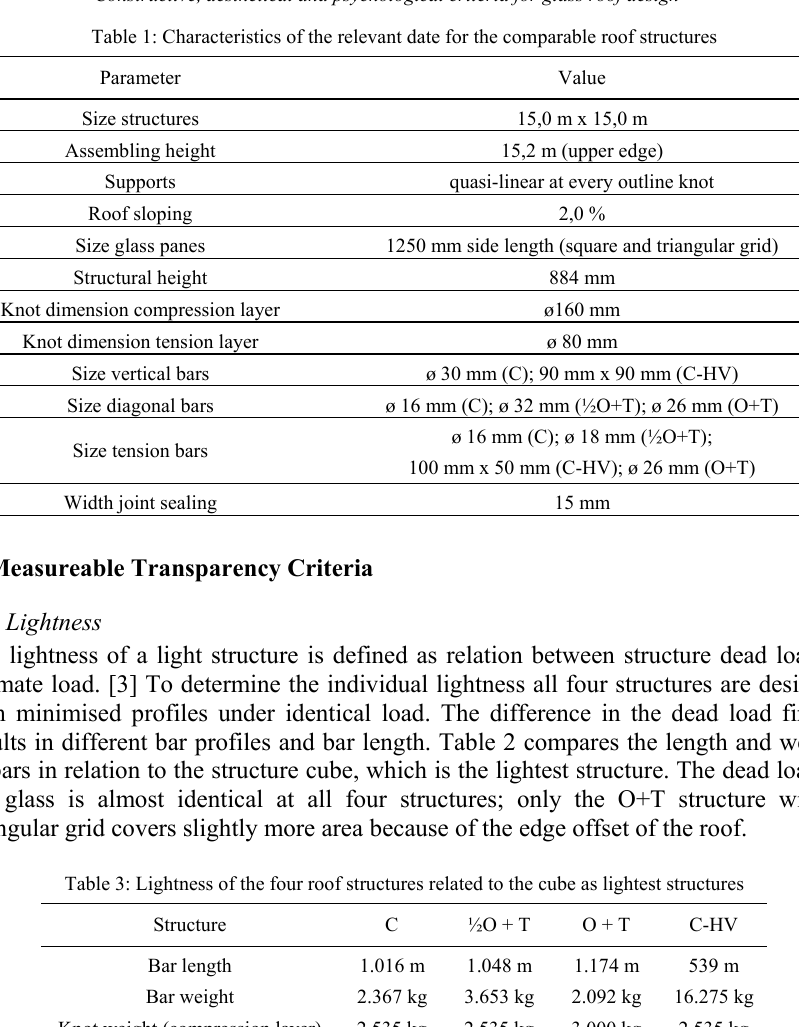
Table 3: Lightness of the four roof structures related to the cube as lightest structures Structure